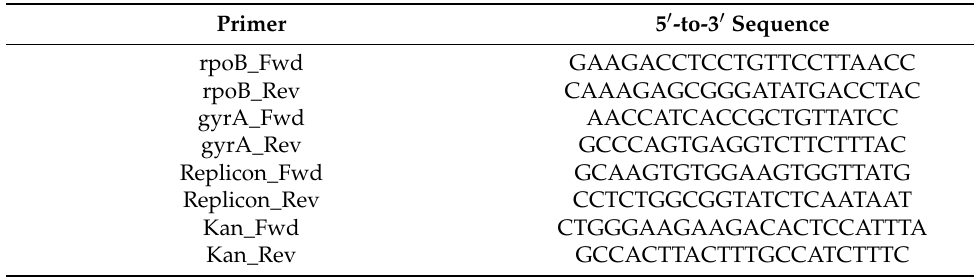
Table 4. List of qPCR primers used in this